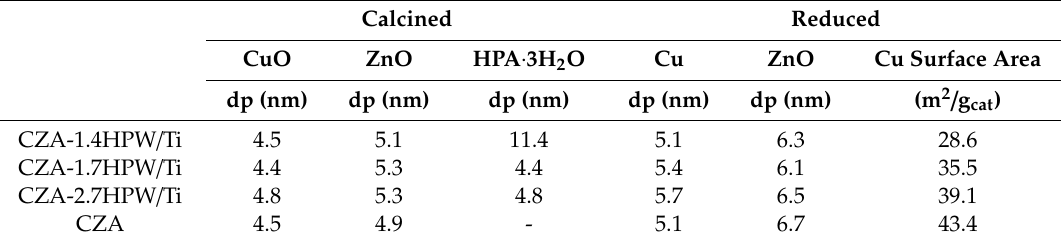
Table 3. Crystallite size (nm from XRD) of Cu, CuO and ZnO in CZA and CZA-xHPW / Ti hybrids catalysts in calcined and reduced state and specific surface area (N 2 O chemisorption) of copper in reduced hybrid